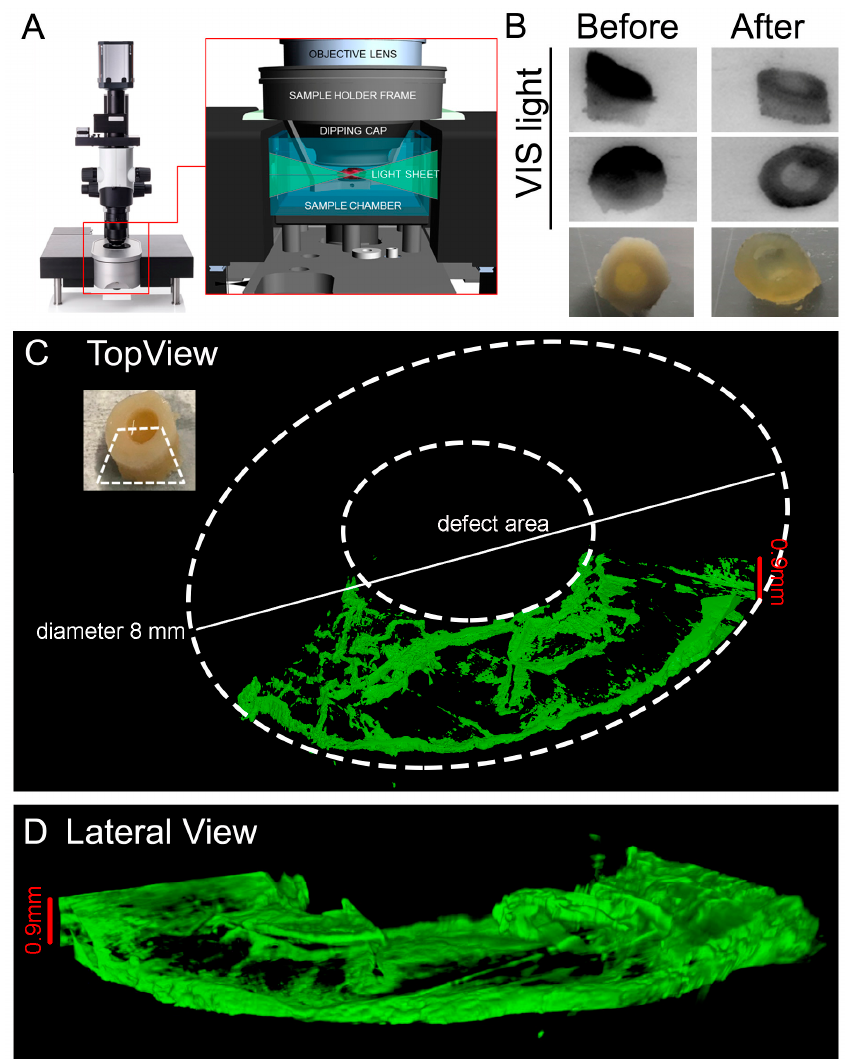
Figure 7. Light sheet microscopy on the whole cleared OC plugs. ( A ) Picture representing the UltraVision Ultramicroscpe used to image the OC plugs. ( B ) Representative pictures of the OC plugs with visible (VIS) light and camera before and after the clearing procedure. ( C , D ) Representative 3D rendered image of a section of the OC plug cleared and then stained with Collagen Type II (shown in green).